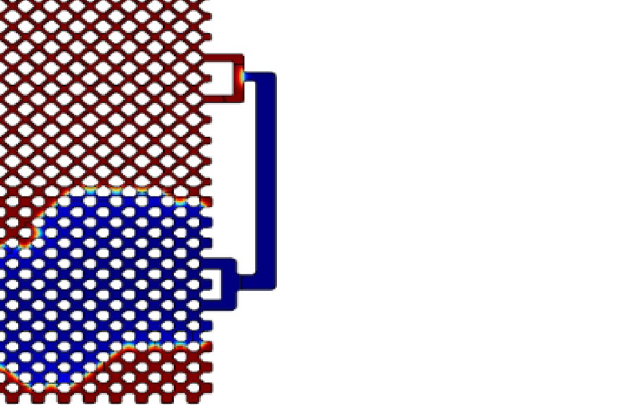
Figure 3. Modeling results for water